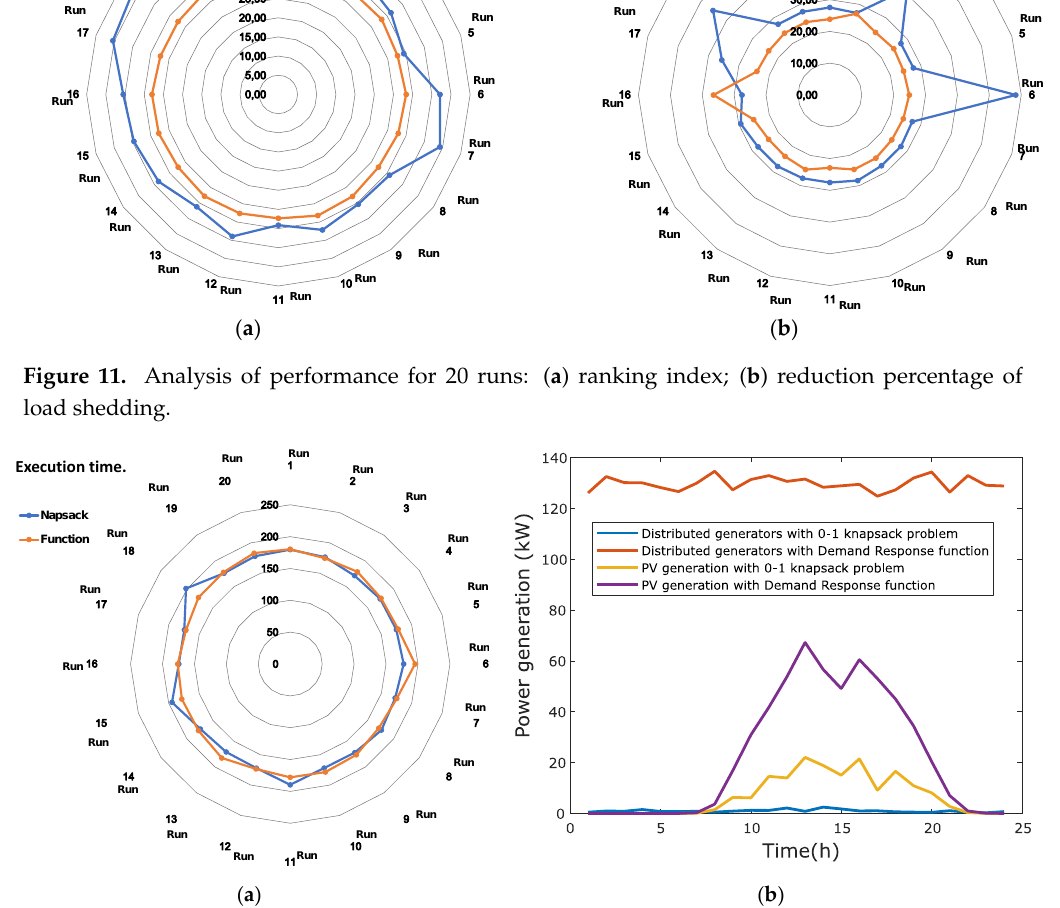
Figure 11. Analysis of performance for 20 runs: ( a ) ranking index; ( b ) reduction percentage of load shedding.